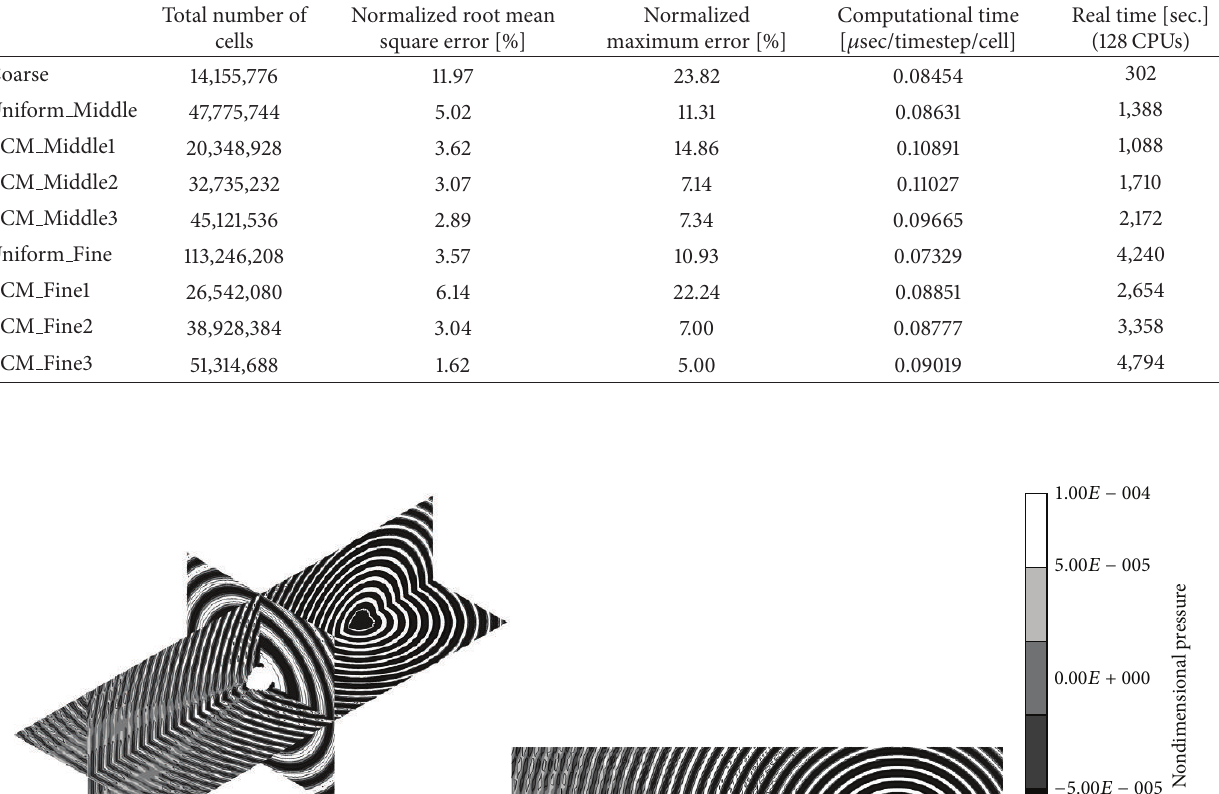
Table 3: Comparison of errors relative to an analytical solution and respective computational times for the meshes listed in Table 2.